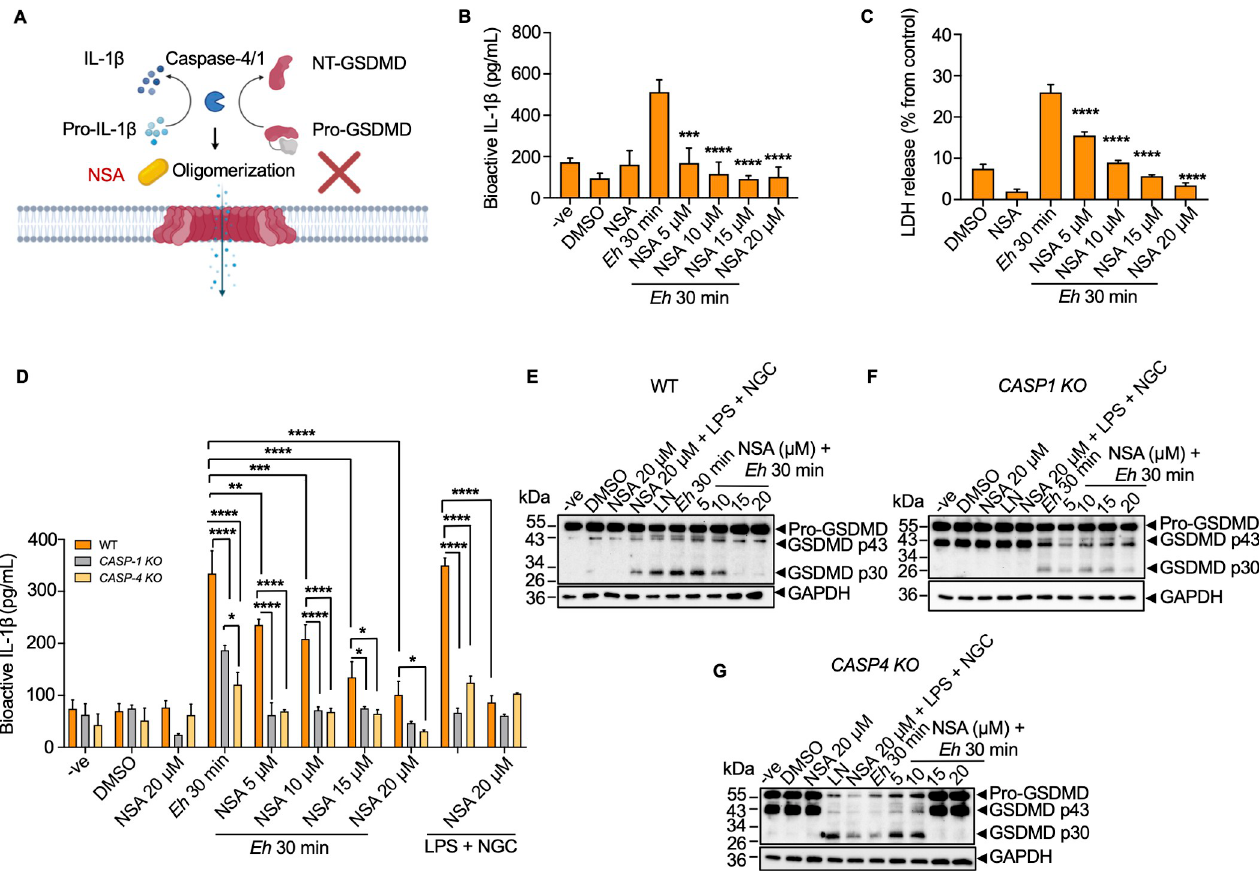
Fig 10. Gasdermin D pores function as gatekeepers of IL-1 β release in response to E . histolytica . ( A ) Necrosulfonamide (NSA) as a direct chemical inhibitor of GSDMD, binds directly to GSDMD, inhibiting oligomerization of GSDMD p30 pore-forming fragment to inhibit pyroptosis. ( B ) NSA was added to macrophages 60 min prior to Eh stimulation. Since NSA was prepared in dimethyl sulfoxide (DMSO), DMSO, NSA only (20 μ M) were used to detect if DMSO or NSA itself would have any effect on THP-1 cells, and unstimulated cells acted as the negative control. After Eh stimulation, cell free supernatant was added to HEK-Blue IL-1 β reporter cells to detect bioactive IL-1 β using the SEAP assay. ( C ) Pyroptotic pore formation and cell death were assessed through LDH release, cell free supernatants from the same experiments were used to quantify LDH released into the culture supernatant and is shown as a percentage of LDH release compared to non-stimulated cells. ( B, C ) Eh treatment only as a positive control and statistical significance was calculated between Eh 30 min and various concentration of NSA treatments. ( D ) Cell free supernatant was added to HEK-Blue IL-1 β reporter cells to detect bioactive IL-1 β using the SEAP assay to detect NSA inhibition in GSDMD pore formation in WT, CASP1 KO , CASP4 KO macrophage. LPS (50 ng/mL) and NGC (10 μ M) stimulation for 60 min acted as the positive control. Statistical significance was calculated between WT and KO macrophages and between CASP1KO and CASP4 KO macrophages at each time point. ( E-G ) Immunoblot analysis was performed for GSDMD p30 cleavage in cell lysates (LYS), and blots were reprobed for GAPDH. WT, CRISPR/ Cas9 CASP1 KO and CRISPR/Cas9 CASP4 KO macrophages were pre-incubated with NSA for 60 min before stimulation with LPS + NGC. Data and immunoblots are representative of six experiments (n = 6) and statistical significance was calculated with Student’s t-test and one-way ANOVA followed by post hoc Bonferroni test, ( � p < 0.05, �� p < 0.01, ��� p < 0.001, ���� p < 0.0001). Bars represent mean ±